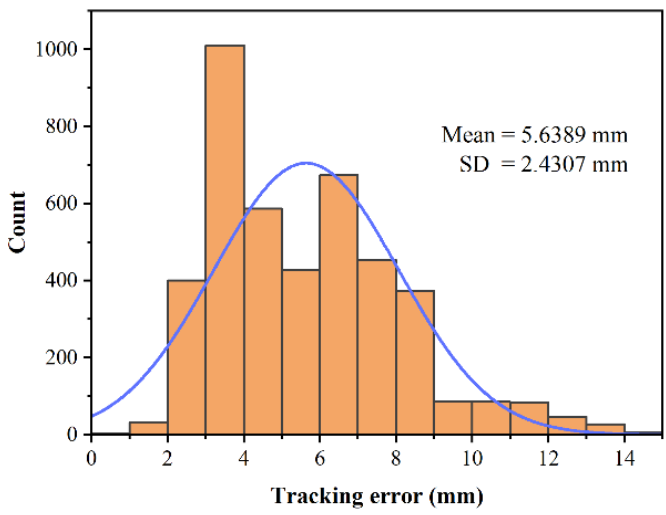
Figure 6. Statistical results of end effector position errors .